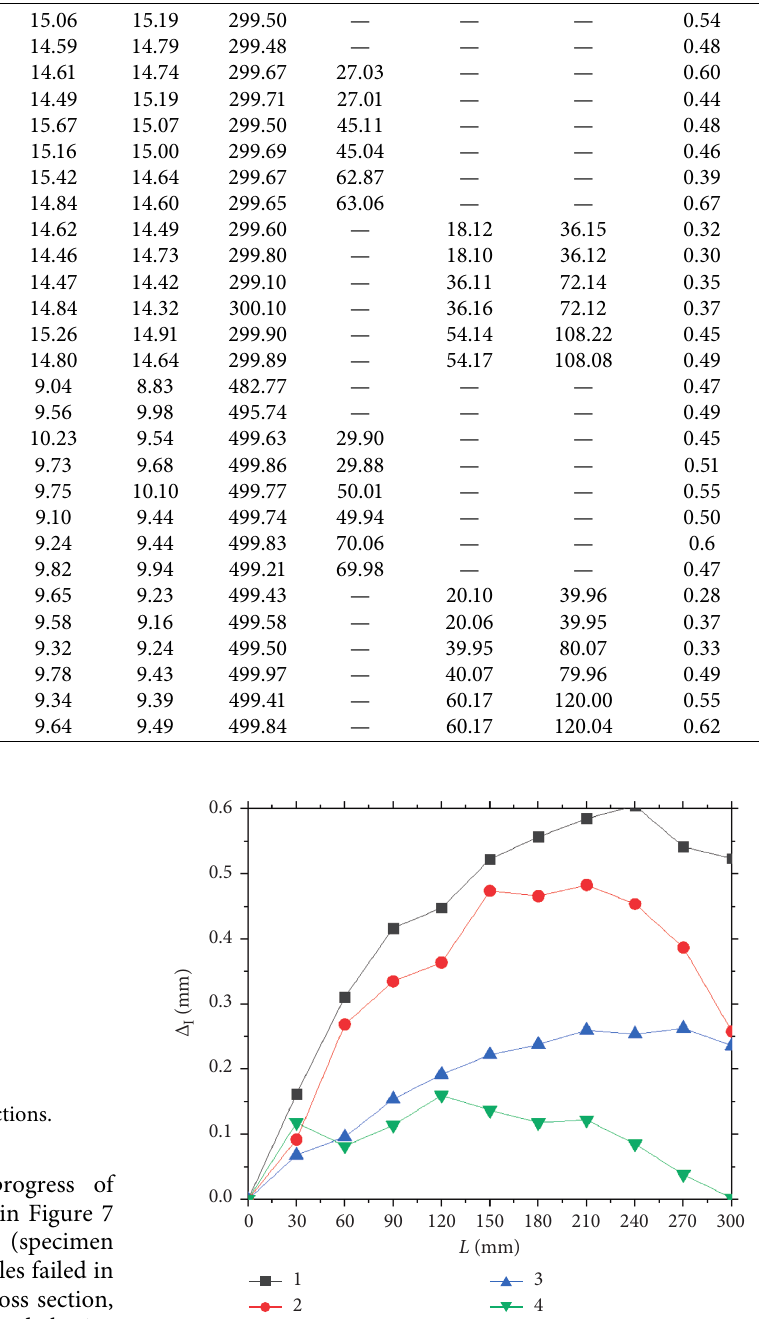
Figure 4: Initial imperfections of specimen C9008-03-CH3-1.